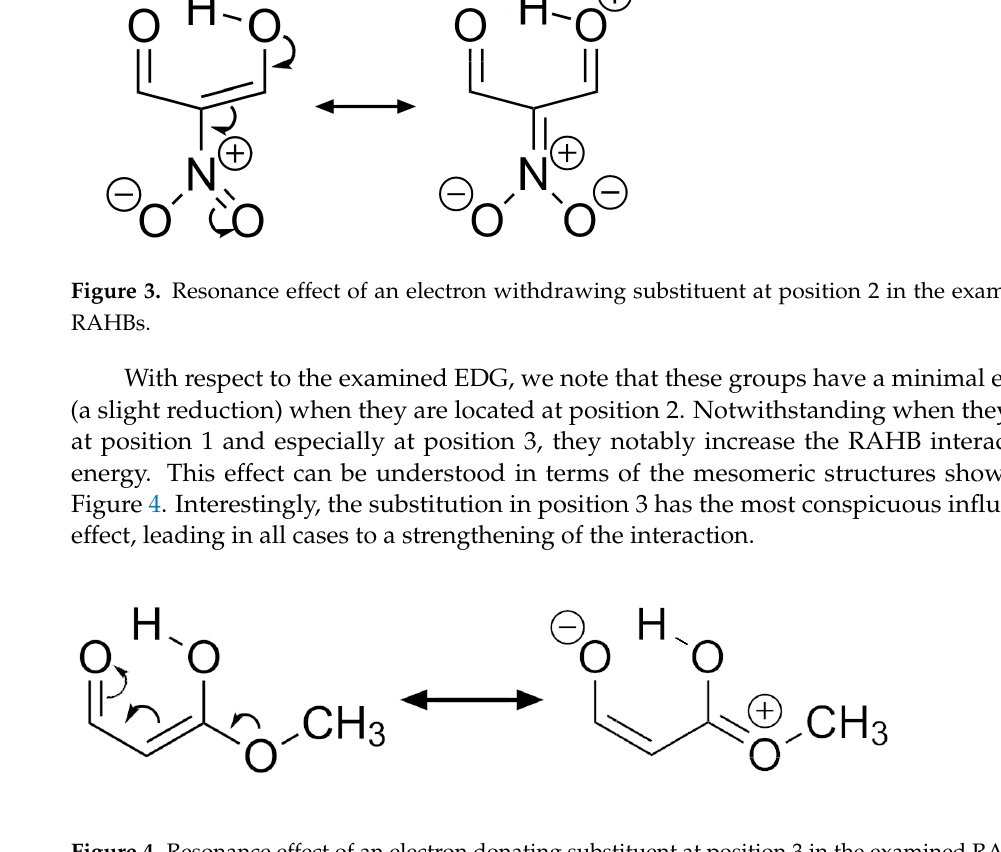
Figure 4. Resonance effect of an electron donating substituent at position 3 in the examined